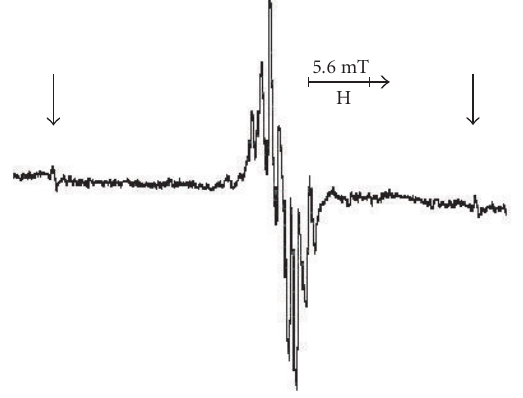
Figure 2: The ESR spectrum with seven superfine components ( Δ H = 1 . 13mT, g -factor 2 . 001) of irradiated collagen (77K; pH 3 . 7).